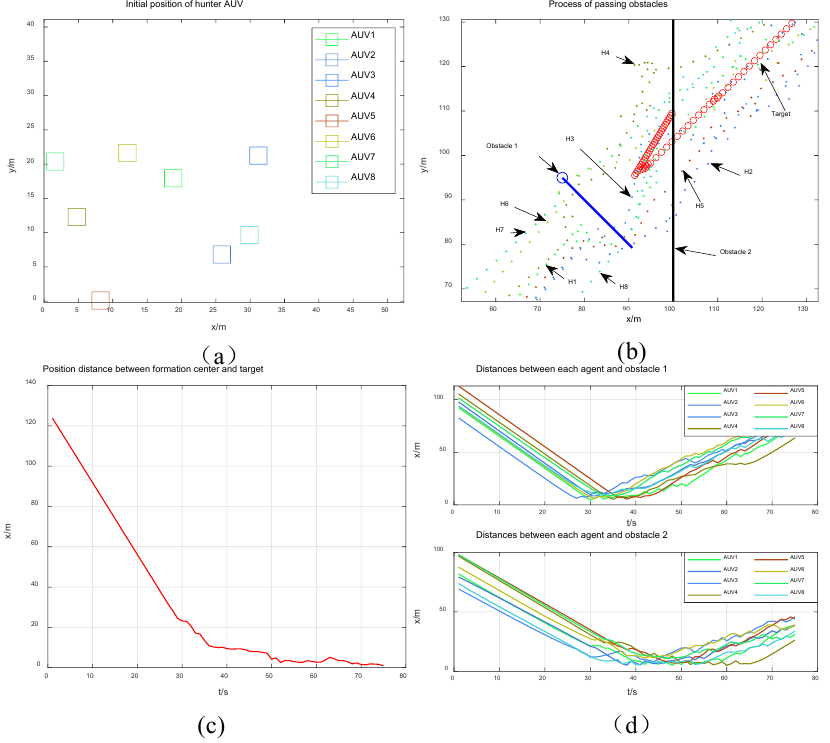
Figure 11. APF-based method in dynamic environment: ( a ) The initial position of hunter AUV; ( b ) process of passing obstacles; ( c ) position distance between formation center and the target; ( d ) distances between each agent and obstacle 1 and 2.